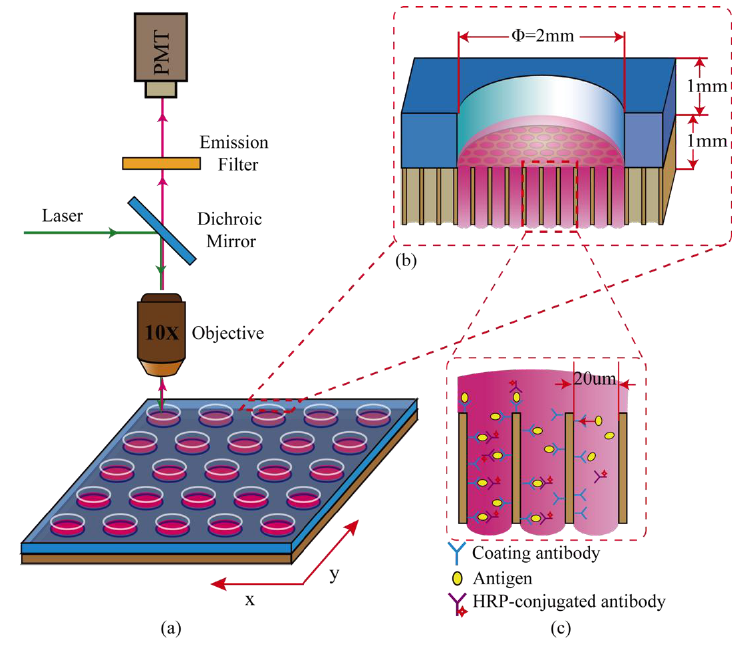
Figure 1. Schematic diagram of the compact immunoassay in a microwell array on MCP, integrated with an x-y stage and a laser-induced fluorescence measurement system ( a ), cross-section of a single microwell consisting of MCP and a PDMS slide ( b ), and the schematical illustration of the compact ELISA performed in microchannels within MCP, in which each microchannel with 20 μm diameter is acted as a micro-reactor with short diffusion distance ( c